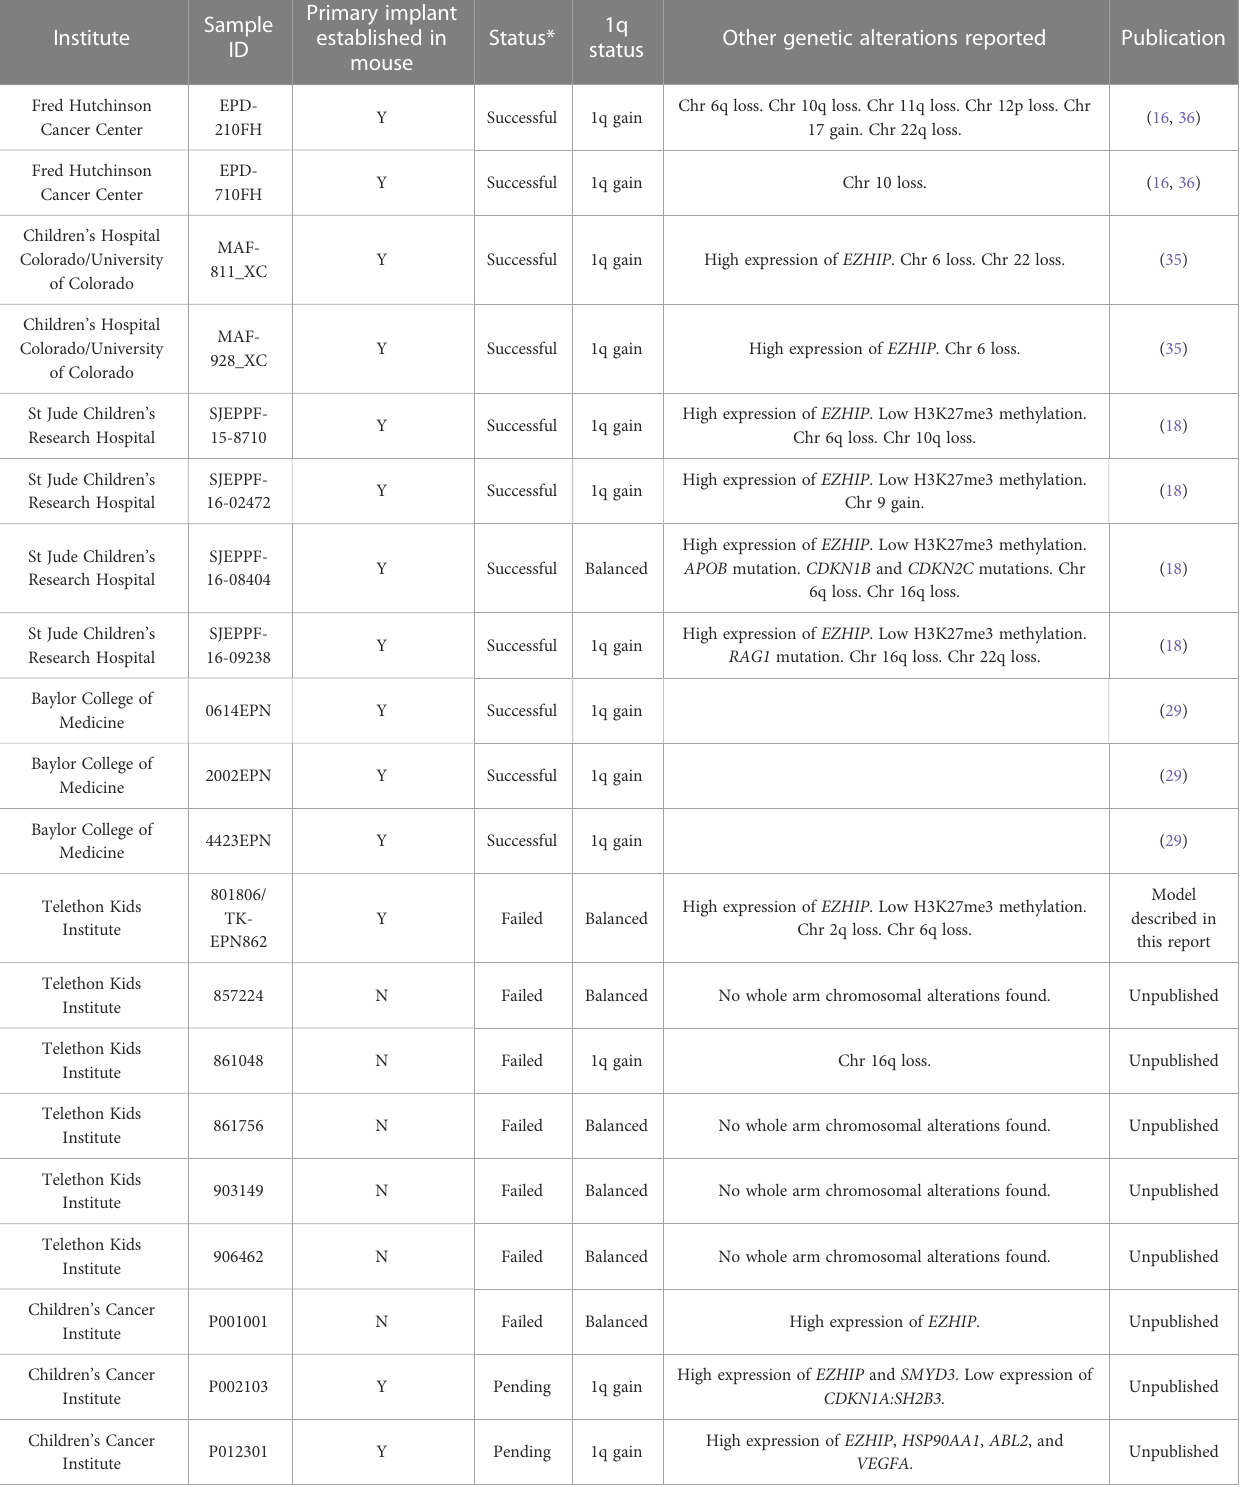
TABLE 1 1q gain is associated with an increased likelihood of establishment success of PFA EPN PDOX